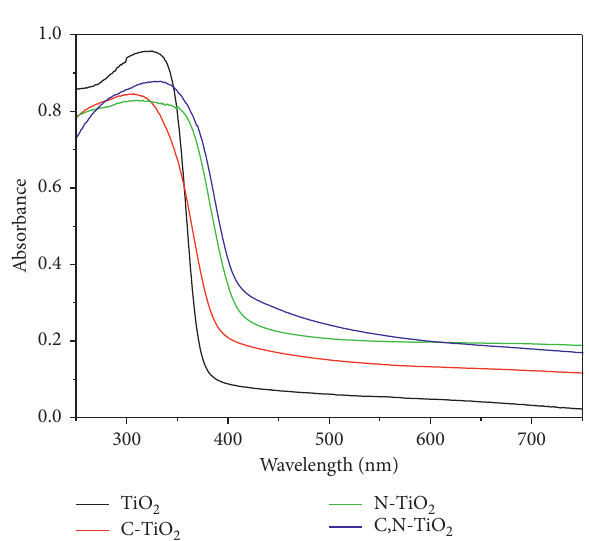
Figure 3: UV-VIS spectra of TiO